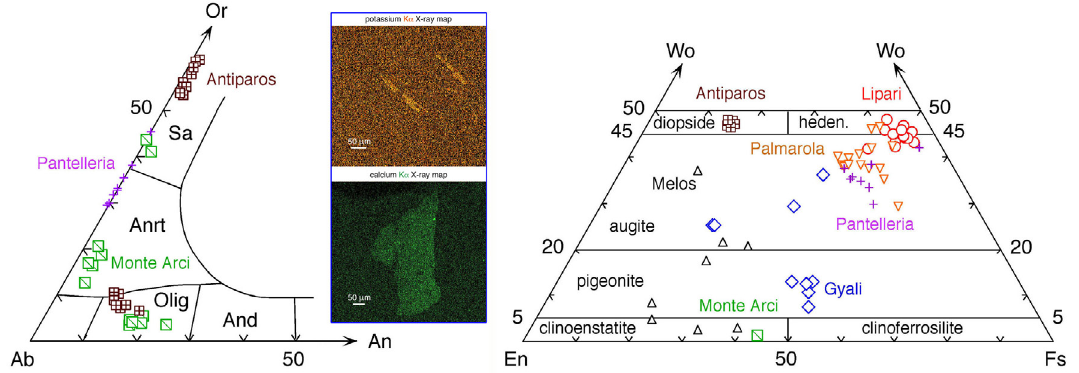
Figure 4. The left-hand diagram shows the composition of the Antiparos feldspars plotted in the Ab-An-Or diagram; Monte Arci and Pantelleria feldspars (data from Acquafredda & Paglionico, 2004) are plotted for comparison. In the blue-bordered inset the X-ray map images used to identify the presence of feldspar crystals: in orange the sanidines (sample Ant 17) and in green the plagioclases (sample Ant 6). The right-hand diagram shows the compositions of pyroxenes according to the Morimoto et al. (1989) nomenclature for the major obsidian source areas in the Mediterranean (Acquafredda & Paglionico, 2004), including the new data from the Antiparos samples. Ab: albite; An: anorthite; Or: orthoclase; Sa: sanidine; Anrt: anorthoclase; Olig: oligoclase; And: andesine; En: enstatite; Fs: ferrosilite; Wo: wollastonite.